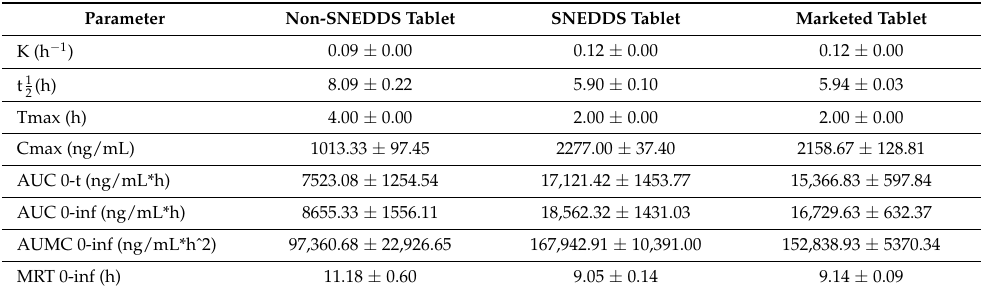
Figure 8. Plasma concentration–time curves of glimepiride after oral administration of the SNEDDS, non-SNEDDS, and marketed tablets to induced-hyperglycemic male Wistar rats ( n = 6). # and $ Indicate significant difference between the Non-SNEDDS and marketed tablets, respectively, at p -value < 0.05. Table 7. Pharmacokinetic parameters of glimepiride after oral administration of 10 mg/kg in rats ( n = 6, the data expressed as mean ±